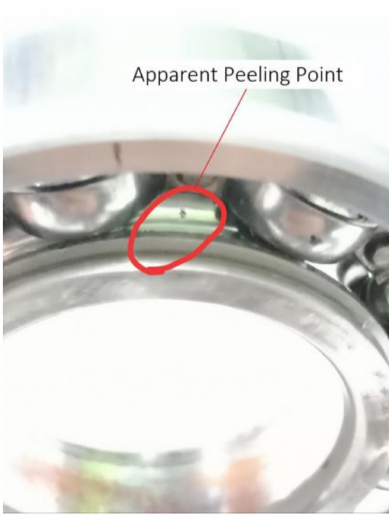
Figure 13. Peeling failure in inner ring of bearing after running for about 128